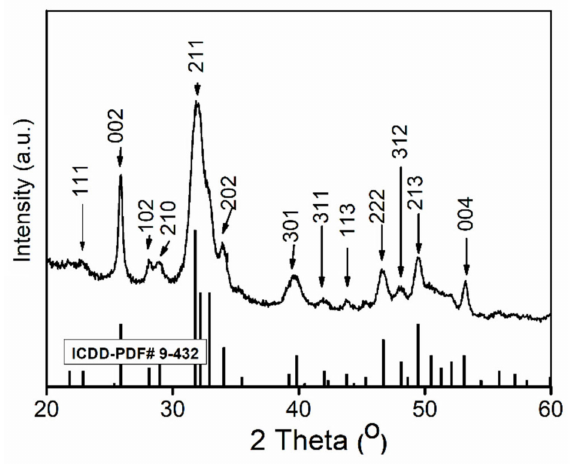
Figure 1. X-Ray Diffraction (XRD) patterns of the HAp-CTAB